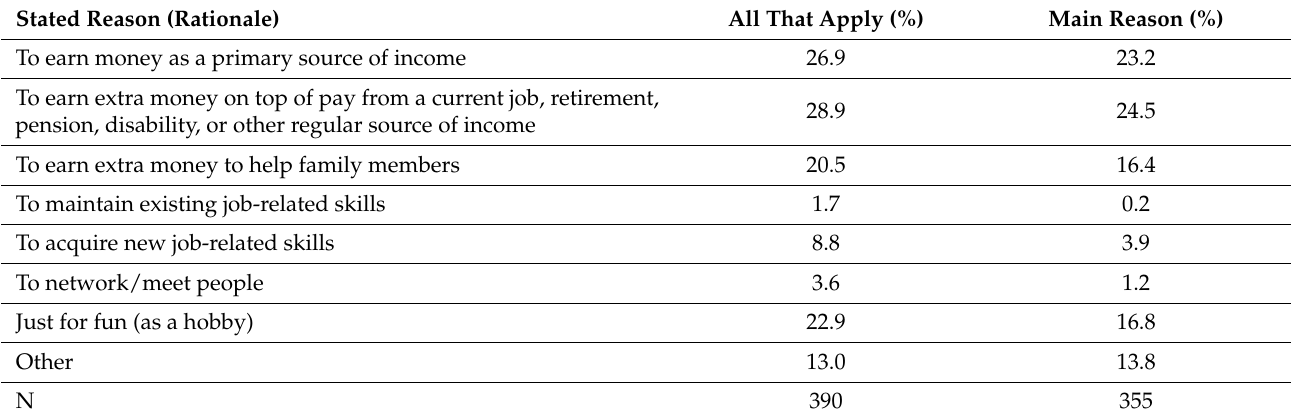
Table 7. Stated Reasons (Rationale) for Engaging in EIWA for